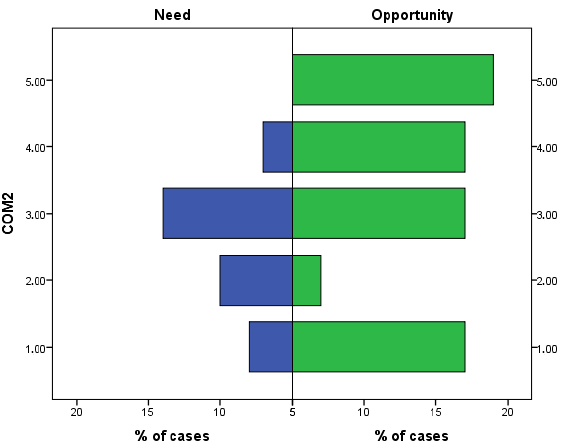
Figure 7. Barplot of COM2 (use of cutting-edge technology) split per need and opportunity.